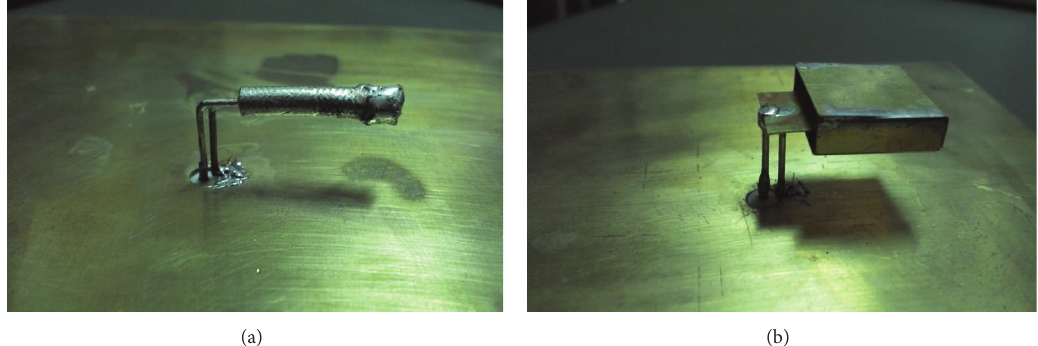
Figure 12: Prototypes of proposed antennas. (a) Reduced IFA, and (b) reduced PIFA.